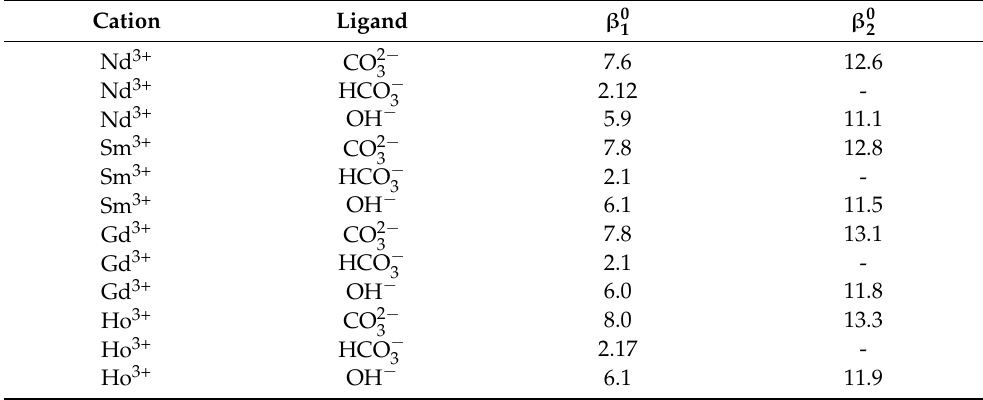
Table 2. Stability constants.